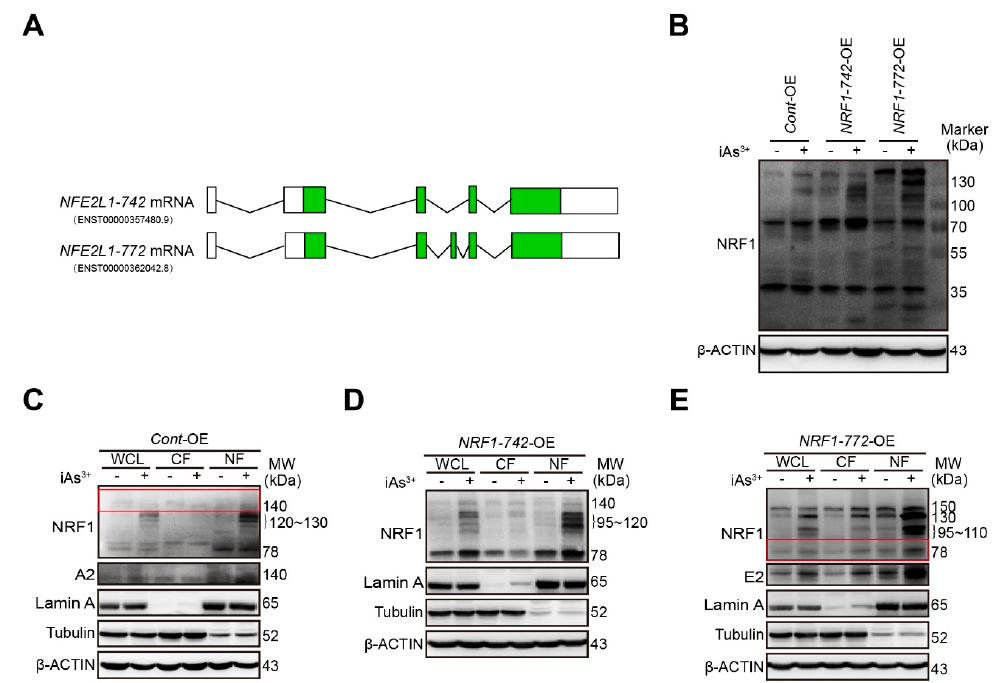
Figure 1. Detection of endogenous NRF1-742 and NRF1-772 proteins and their nuclear accumulation. ( A ) Schematic diagram of different isoforms of the human NRF1 transcripts. Green and white open boxes represent the coding and untranslated regions, respectively. The solid black lines represent the introns. The sequences are from the National Center for Biotechnology ( www.ncbi.hlm.nih.gov ) and Ensemble Genome Browser ( www.ensemble.org ), updated as of November 2019. ( B ) NRF1 protein expression in HaCaT cells exposed to iAs 3+ or vehicle (medium) for 6 h. Whole-cell lysates (WCL), cytosolic fractions (CF), and nuclear fractions (NF) from Cont -overexpressing (OE) ( C ), NRF1-742 -OE ( D ), and NRF1-772 -OE cells ( E ) following treatment with vehicle (medium) or 10 μ M iAs 3+ for 6 h. To better visualize the weak bands, the films with weak bands (red boxes) were cut for another longer exposure following the initial exposure of the whole membrane (labeled as A2, E2).